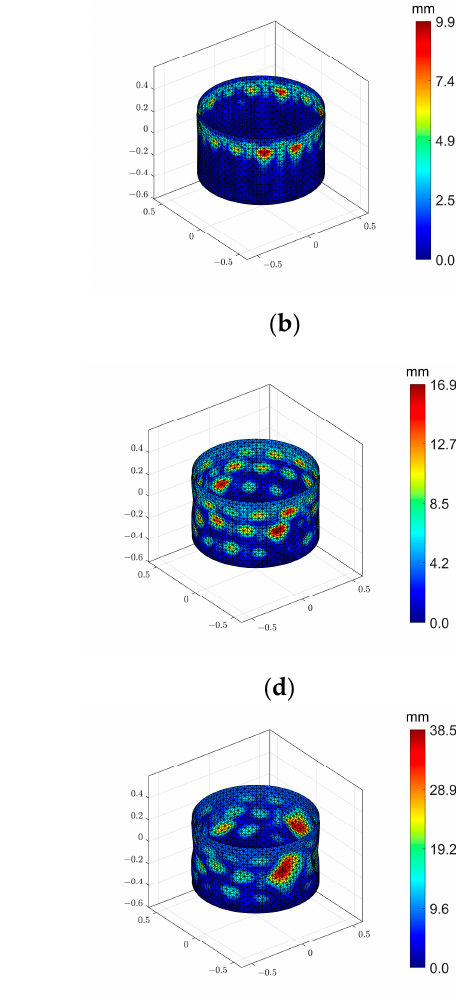
( f ) Figure 10. Postbuckling of 2 × 120° local axial compression: :( a ) before buckling, ( b ) first buckling, ( c – f ) second buckling. Finally, the postbuckling behavior of overall axial compression is simulated as a con- trol, and the postbuckling of the circular tube is achieved by applying a forced axial dis- placement of 8 mm downward from the end of the tube to the circular tube. Figure 11 is the displacement contour of the structure in the whole loading process after buckling, Figure 11a shows that the first buckling occurs just at the beginning, the element extrusion deformation first appears at the location where the depression is about to occur, Figure 11b depicts the gradual formation of the depression at the extrusion location to the inside of the tube, the deformation of the depression gradually expands and then the second buckling appears at Figure 11c and the third buckling at Figure 11d. At this time, the de-